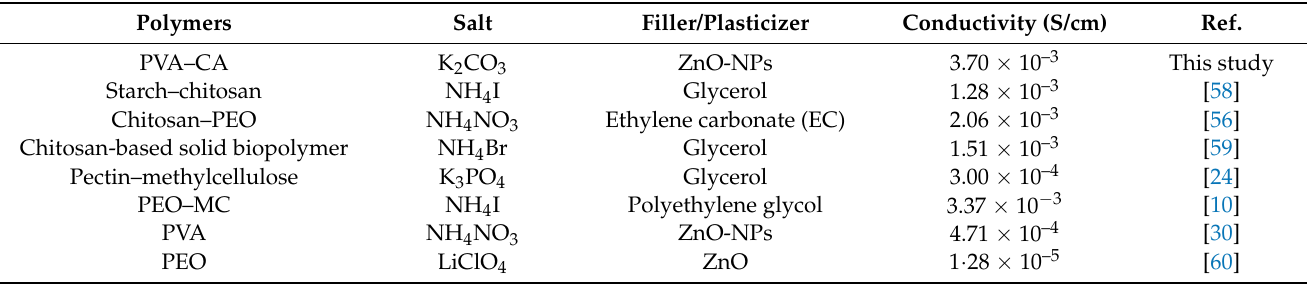
Table 3. Comparison of the conductivities at room temperature of polymer blend SPEs from the literature.